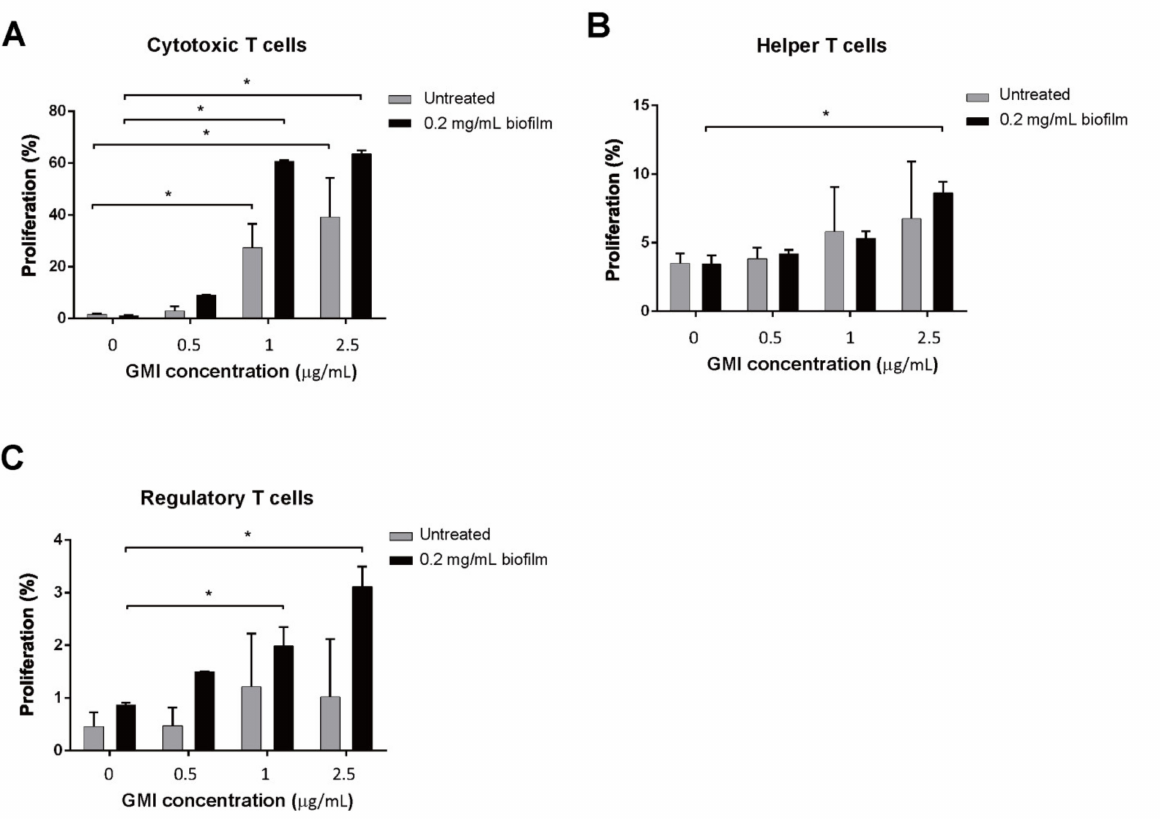
Figure 3. Activation of T cell proliferation that was suppressed by MDSCs. MDSCs that were treated or untreated with biofilm were incubated with GMI. At 24 h after incubation, the cells were cocultured for 48 h with activated CFSE-labeled T cells at a ratio of 0.5:1, and proliferation of Tc ( A ), T H ( B ), and Treg ( C ) cells were examined and enumerated by flow cytometry. The results were analyzed statistically with Student’s t -test. *: p <